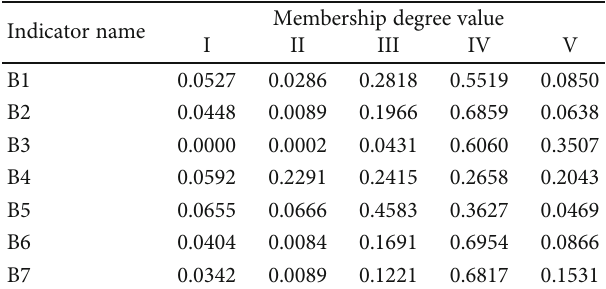
Table 4: Secondary indicators and membership degree of evaluation